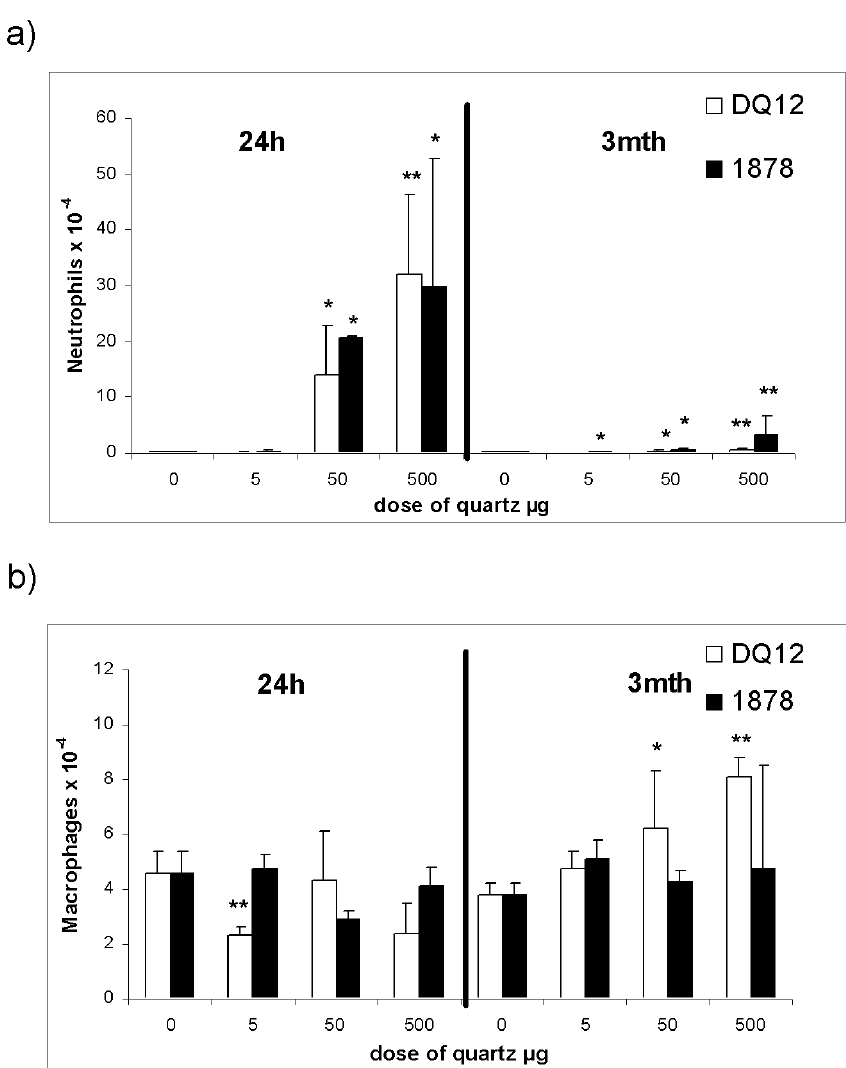
FIGURE 4. Quartz - inflammatory cells in BALF. BALF was collected 24 h or 3 months after a single i.t. instillation of DQ12 (white) or SRM1878a (black) in BALB/c mice. The (a) neutrophil and (b) macrophage content in BALF. Number of cells is shown as the median and 75 th percentile. For explanation of statistical test results (* and **), see Statistics. Each group contained eight